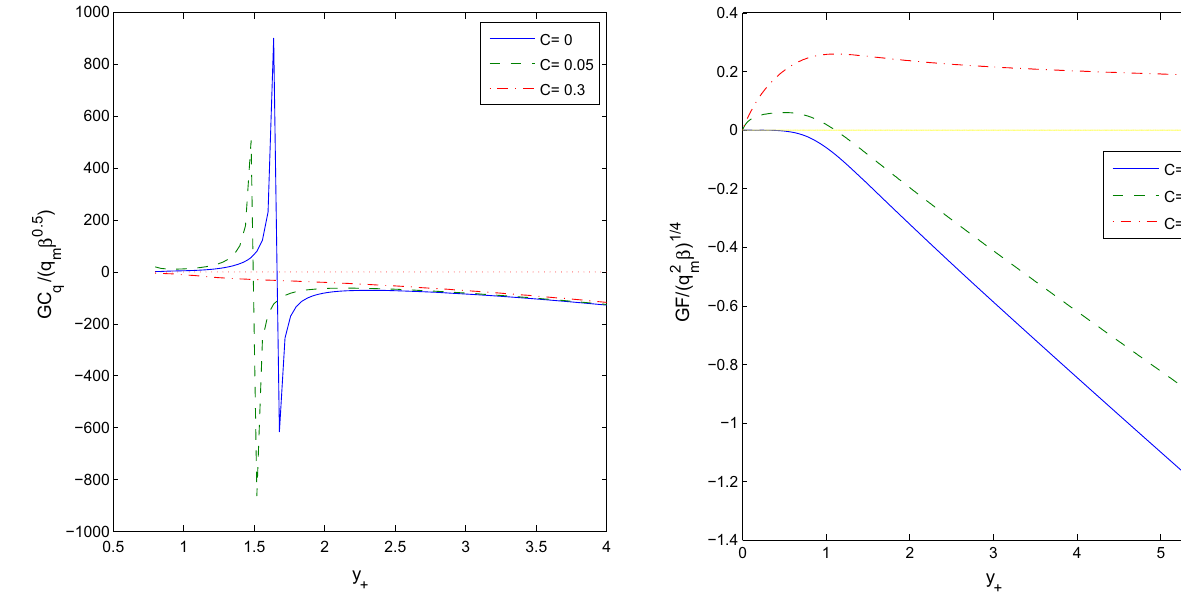
Fig. 4 Theplotofthefunction GC q /( q m corresponds to C = 0 . 05, the solid curve is for C = 0, and the dash- dotted curve corresponds to C = 0 . 3